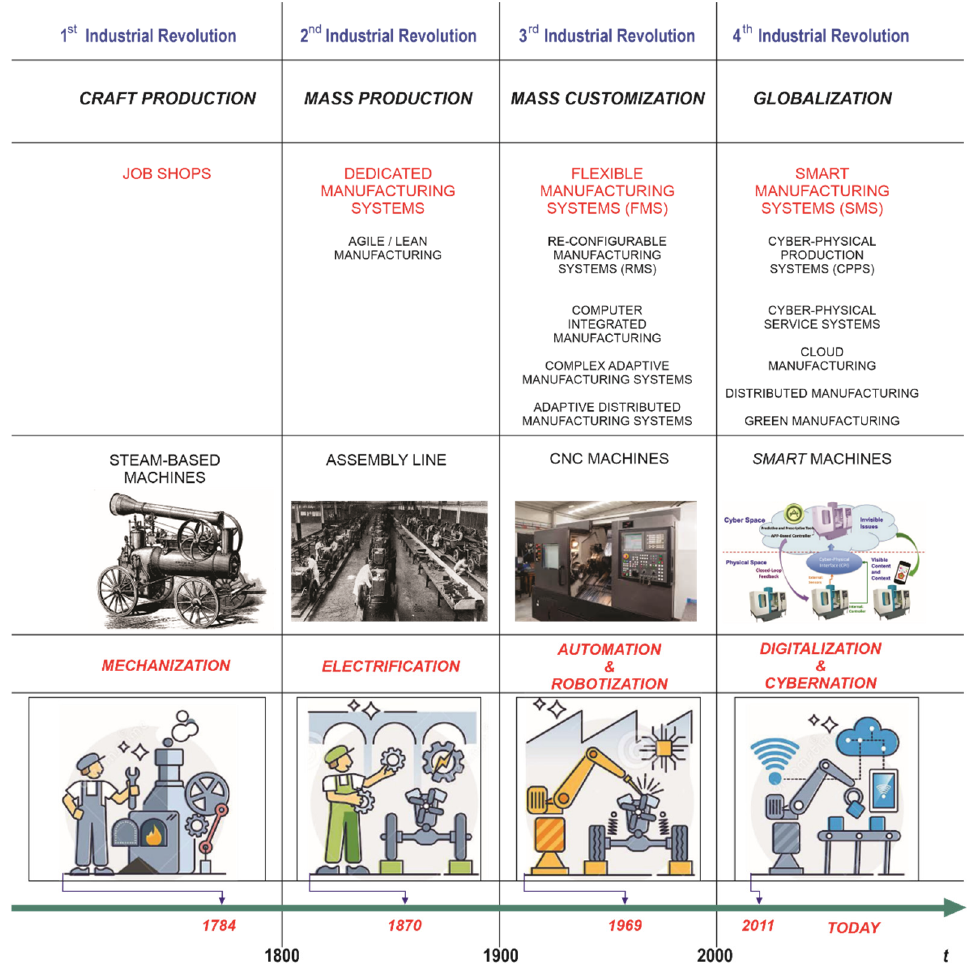
Figure 7. Timeline of Industrial Revolutions.